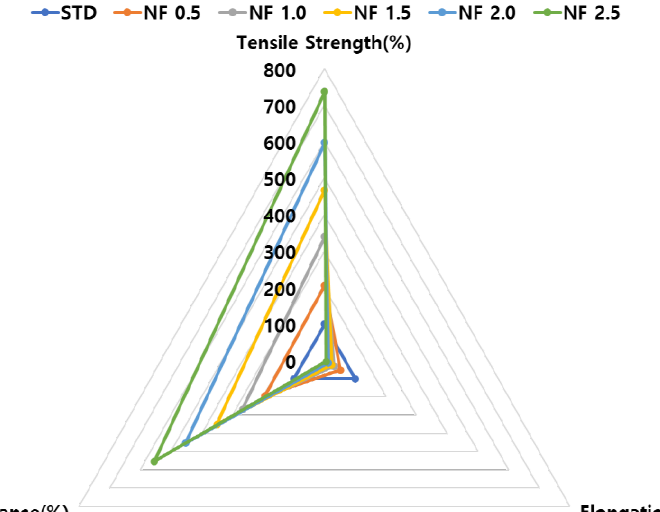
Figure 10. Strength increase/decrease rate according to NF input.